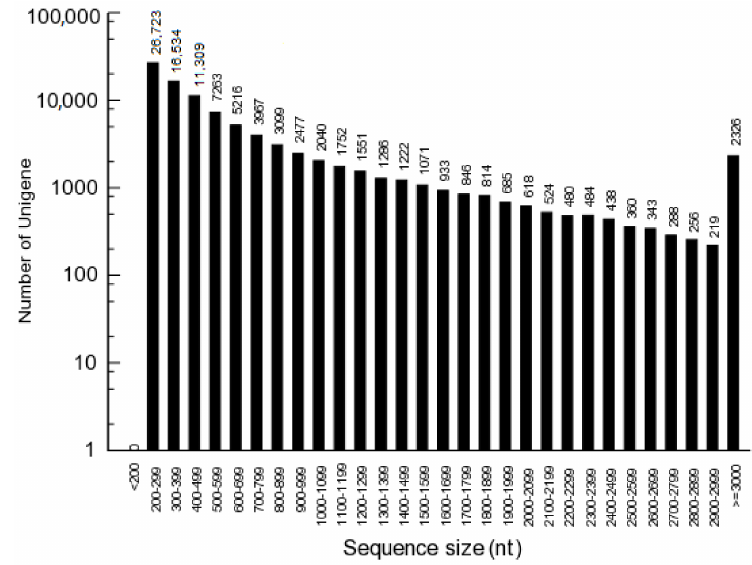
Figure 3. Length distribution of assembled unigenes in C. songaricum .